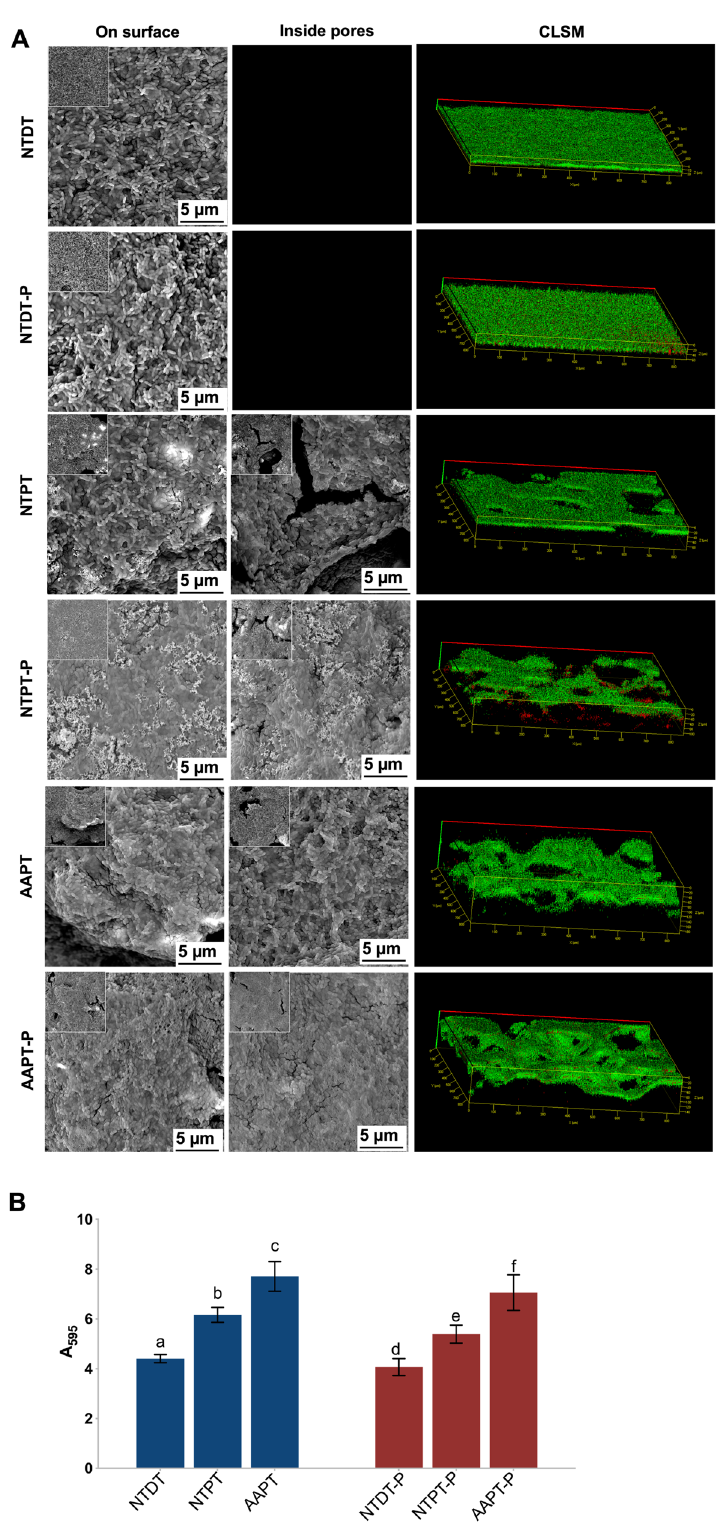
Fig. 4 S. mutans adhesion was fi nally observed at the endpoint (24 h) of incubation on Ti with or without serum precoating. A SEM and CLSM images showed the morphology of bacterial adhesion on NTDT, NTDT-P, NTPT, NTPT-P, AAPT, and AAPT-P. The results showed that more S. mutans cells clustered to form bio fi lms coating all sample surfaces. Bacterial aggregation on AAPT and AAPT-P seemed to be more evident than on NTPT and NTDT as well as on NTPT-P and NTDT-P. B Quanti fi cation of bacterial adhesion in each group was performed by measuring the absorbance at 595 nm ( n = 4). The results showed that bacteria adhered more to porous samples than to dense samples ( p < 0.05). It was also evident that protein coating tended to prevent the bacteria from adhering to material